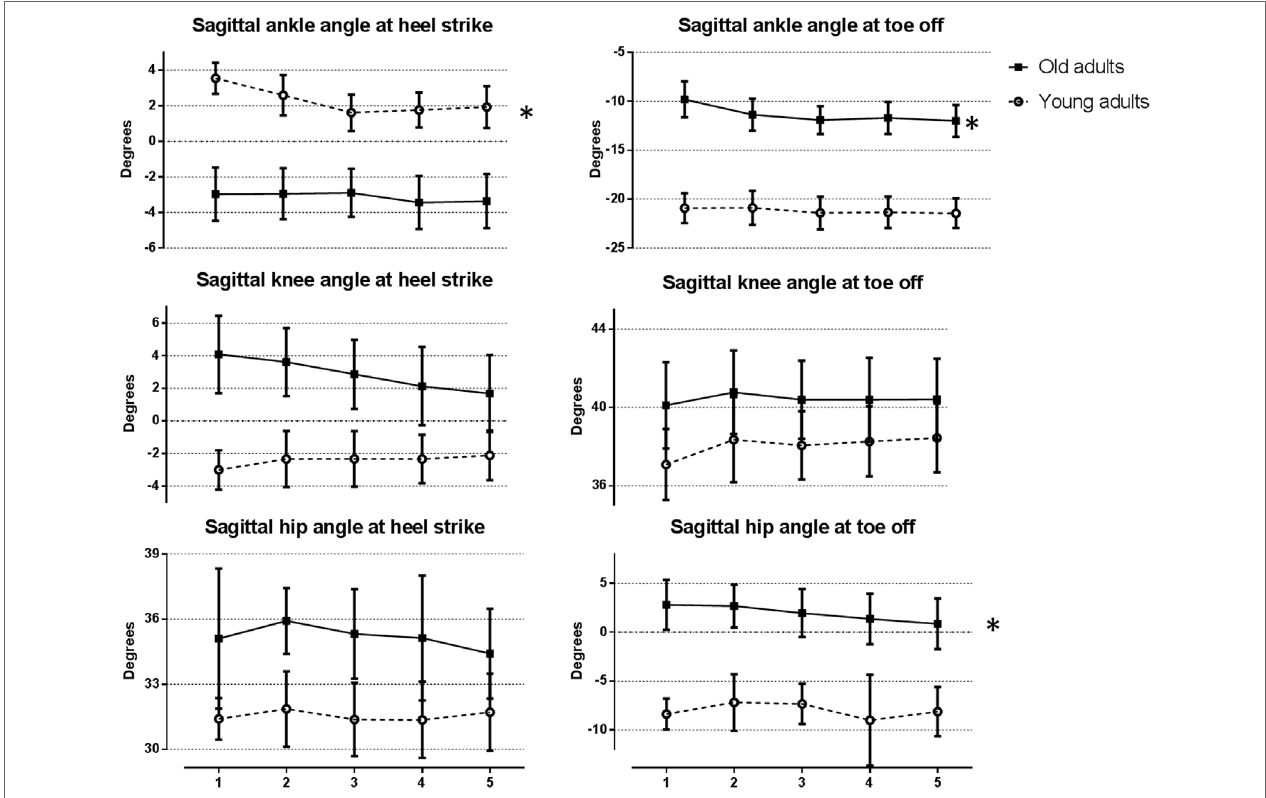
FigUre 2 | Angular displacements for the hip, knee, and ankle at heel strike and toe off in young and old adults during the five time points along the fast-walking activity. *Indicates statistically significant time effect. The mean and SD for each subject were subsequently averaged across subjects within the age-group.